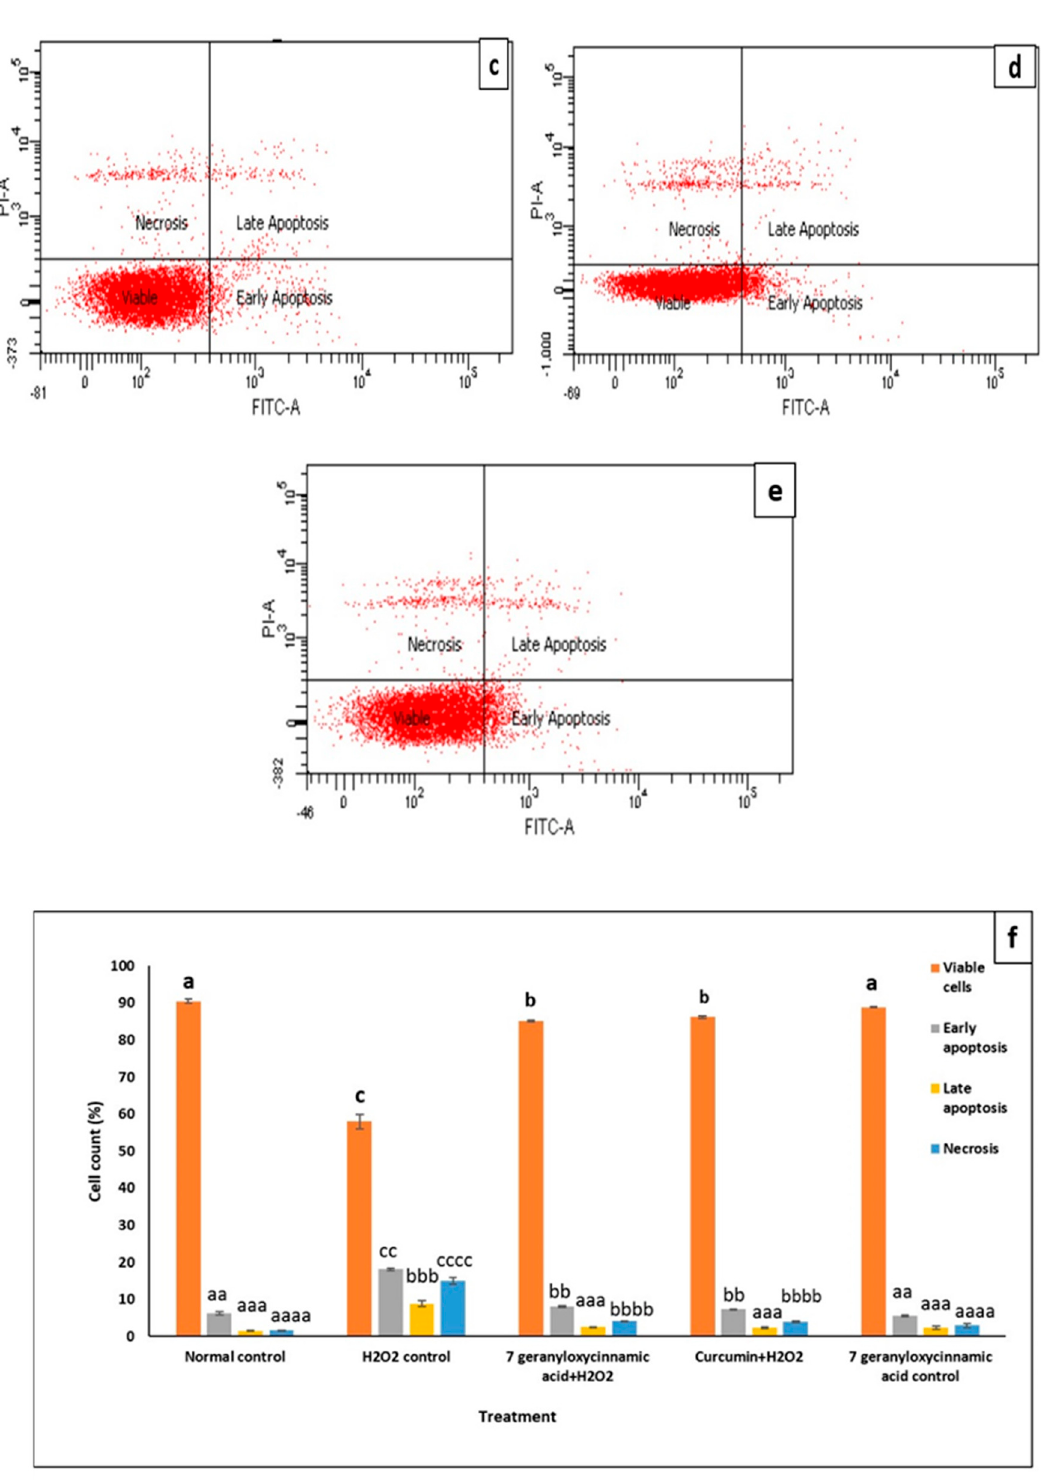
Figure 7. Annexin V-FITC assay of differentiated SH-SY5Y cells using flow cytometry. ( a ) Cells exposed to H 2 O 2 for 4 h. ( b ) Untreated cells. ( c ) Cells pre-treated for 72 h with 2.08 µM 7-geranyloxycinnamic acid. ( d ) Cells pre-treated for 72 h with 2.08 µM 7-geranyloxycinnamic acid and then exposed to H 2 O 2 for 4 h. ( e ) Cells pre-treated for 72 h with 5.97 µM curcumin and then exposed to H 2 O 2 for 4 h. Data are displayed as means ± SD of triplicate experiments; means with different letters denote significant difference ( p < 0.05) ( f ).